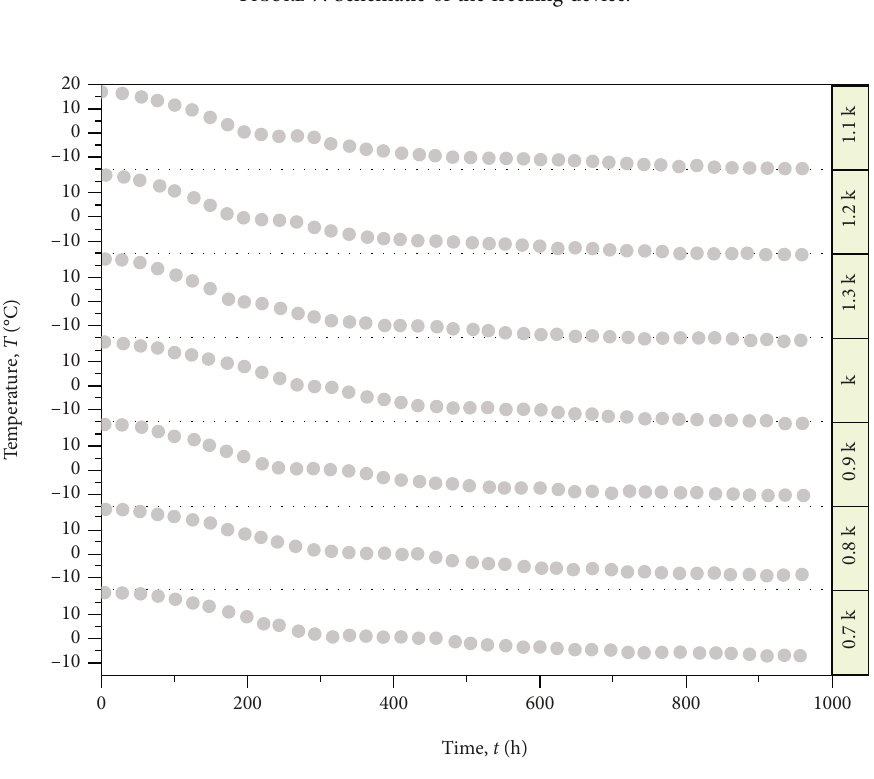
Figure 7: Schematic of the freezing device.